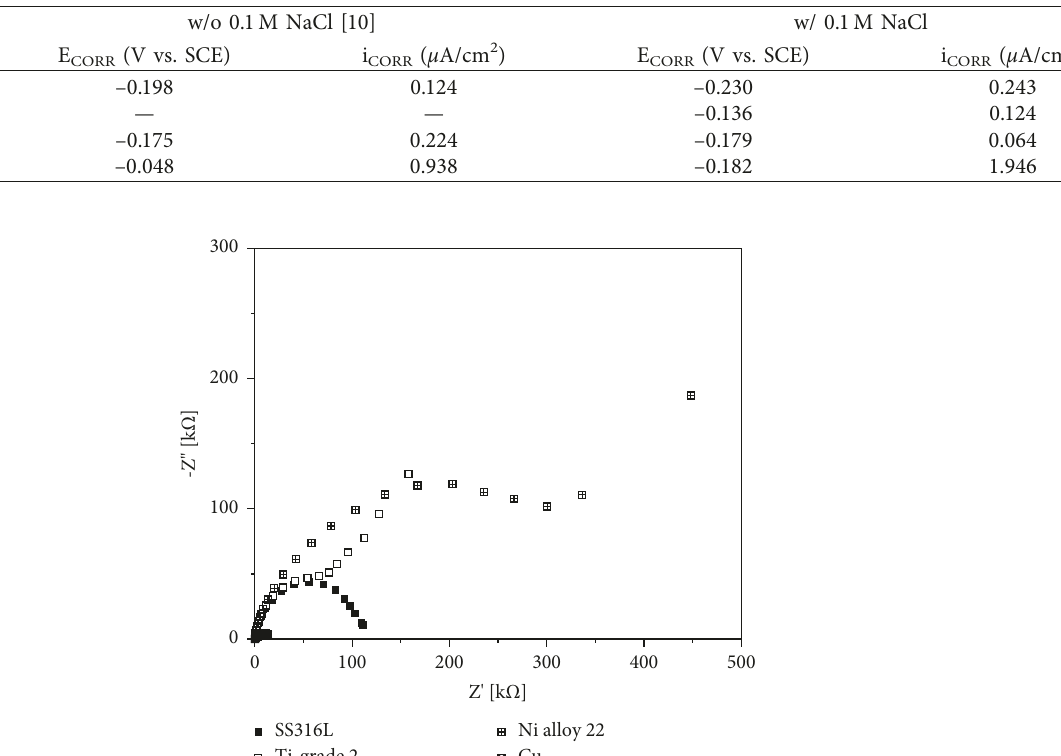
Table 2: Corrosion potential and current of various canister materials in KURT groundwater solution with and without the addition of 0.1M NaCl at 25 ° C.